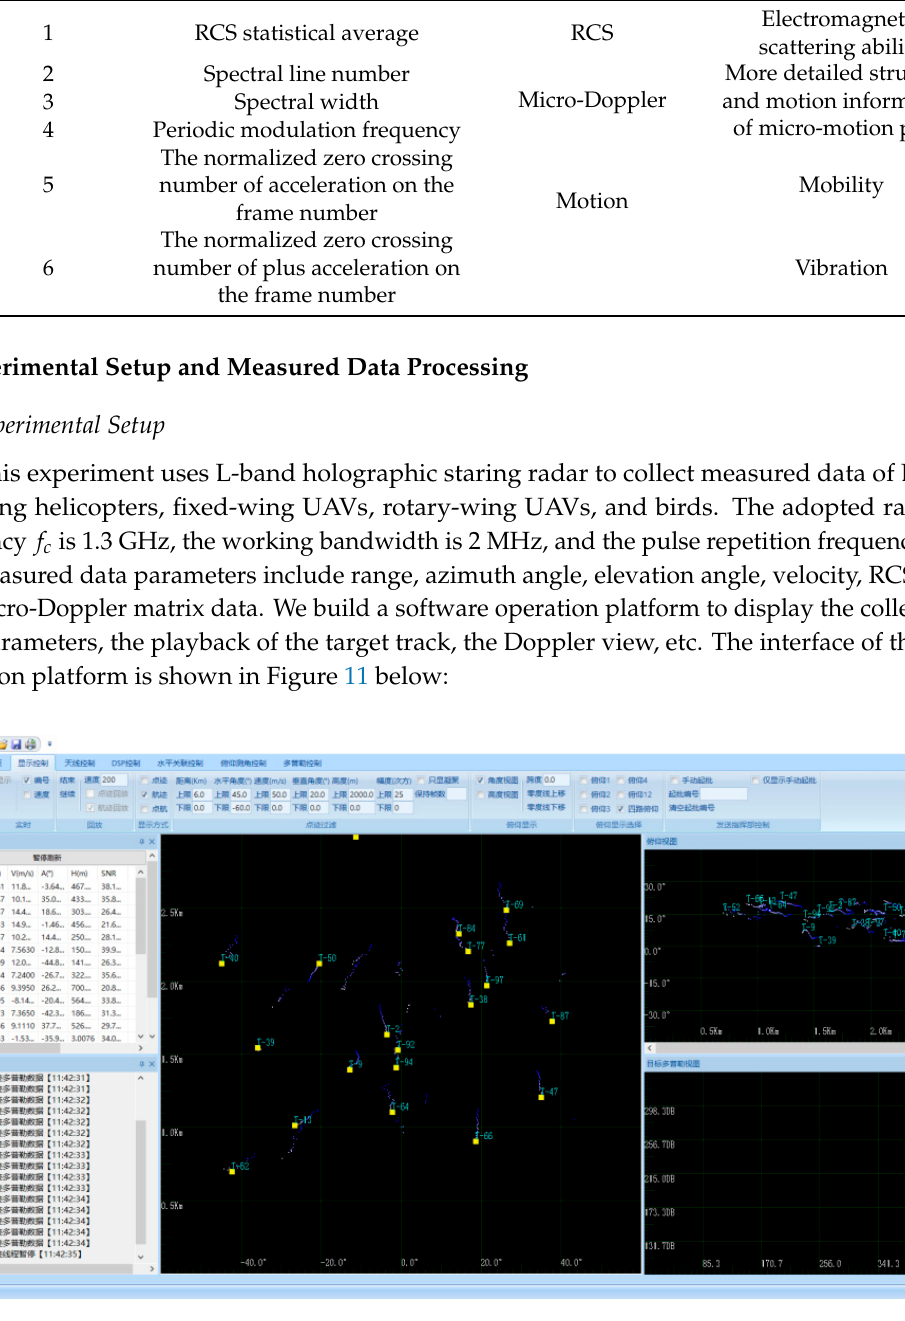
Table 3. Six multi-dimensional features for target recognition.